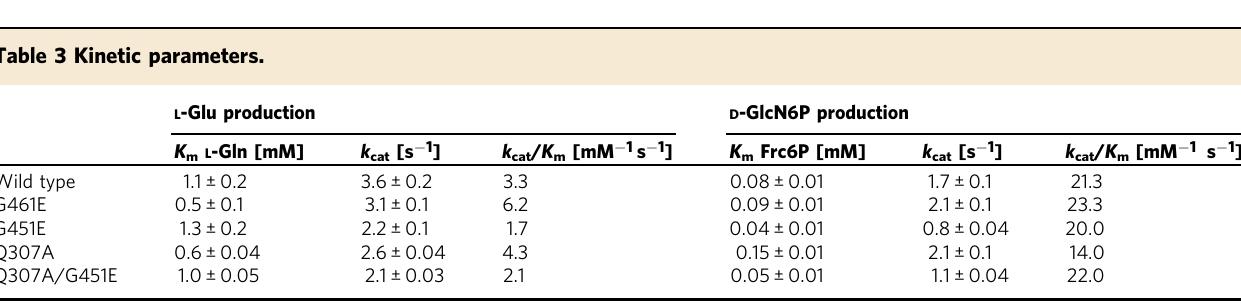
Fig. 4 GFAT-1 inhibition by UDP-GlcNAc and UDP-GalNAc. a – d Structural analysis of UDP-GlcNAc binding to wild type-GFAT-1. Proteins are presented as cartoons. UDP-GlcNAc-bound GFAT-1 is depicted in green and UDP-GlcNAc-free GFAT-1 is colored in purple. Glc6P (yellow sticks), L -Glu (violet sticks), UDP-GlcNAc (white sticks), and Mg 2 + (cyan sphere) are highlighted. a Stereo image of GFAT-1 monomer A. The 2Fo − Fc maps (blue) of the ligands have a contour level of 1.0 RMSD. b Superposition of UDP-GlcNAc-free and UDP-GlcNAc-bound GFAT-1. c UDP-GlcNAc binding site at the isomerase domain. Binding is mediated by residues of the isomerase domain, as well as interactions with Gln310 from the interdomain linker region. Residues involved in UDP- GlcNAc binding are highlighted as sticks, and dashed lines indicate the most important interactions. d Locally occurring side chain movements upon UDP- GlcNAc binding. e Superposition of UDP-GlcNAc-binding site at the GFAT-1 isomerase domain in the presence of UDP-GlcNAc (green structure) or UDP- GalNAc (blue structure). UDP-GlcNAc (white sticks), UDP-GalNAc (black sticks), and Mg 2 + (cyan sphere) are highlighted. f L -Gln kinetic of wild type (WT, black circle) GFAT-1 (mean ± SEM, n = 5). g Representative UDP-GlcNAc (black circle) and UDP-GalNAc (blue triangle) inhibition of wild type